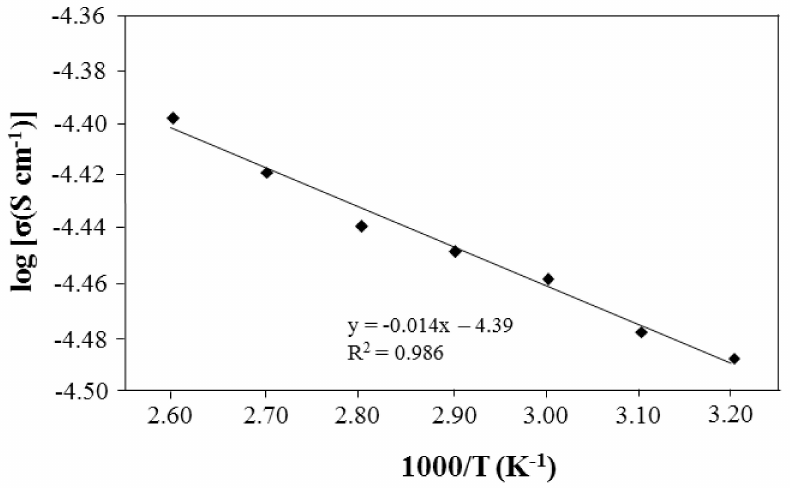
Figure 11. The Arrhenius plot of PU-25LiClO 4 .